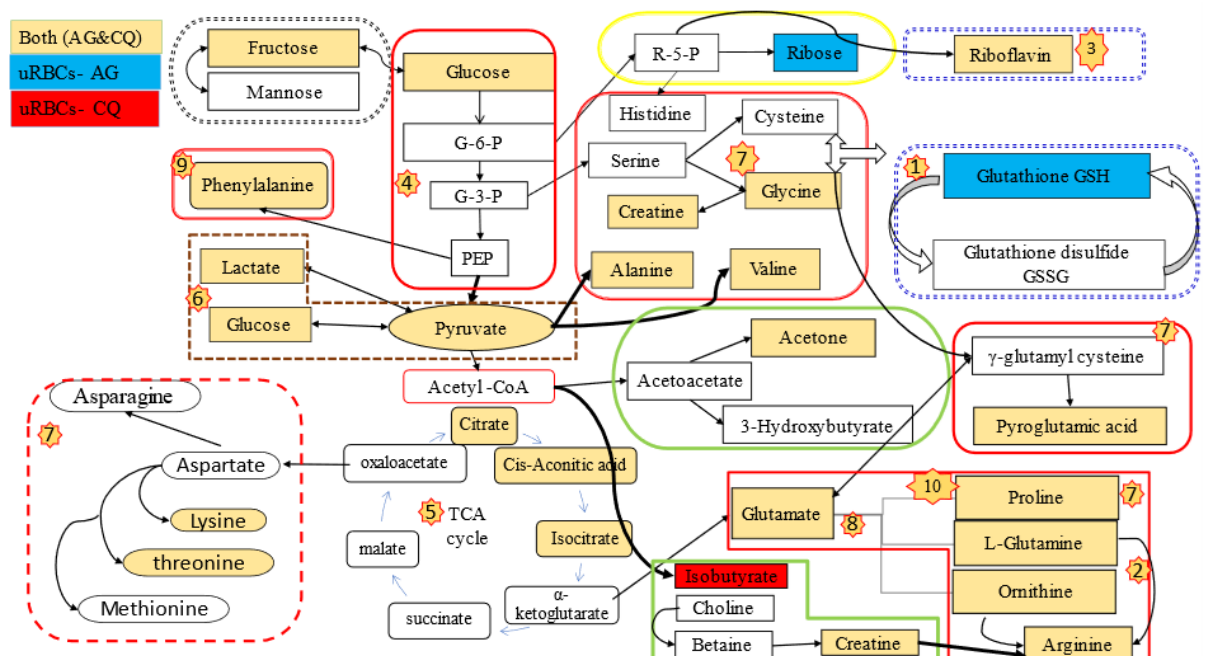
Figure 15. Schematic representation showing the perturbated metabolic pathways of the uninfected RBCs exposed to AG (uRBCs-AG) and the uninfected RBCs exposed to CQ (uRBCs-CQ) as identified by 1 H-NMR. The metabolites that are outlined with light blue are present in uRBCs-AG, red are presents in uRBCs-CQ, whereas those highlighted in gold are present in both treated groups, uRBCs-CQ and uRBCs-AG. The metabolic pathways include, (1) glutathione metabolism; (2) arginine biosynthesis; (3) riboflavin metabolism; (4) glycolysis/c; (5) citrate cycle/TCA cycle; (6) pyruvate metabolism; (7) alanine, aspartate, and glutamate metabolism; (8) D -glutamine and D -glutamate metabolism; (9) phenylalanine metabolism; and (10) arginine and proline metabolism.